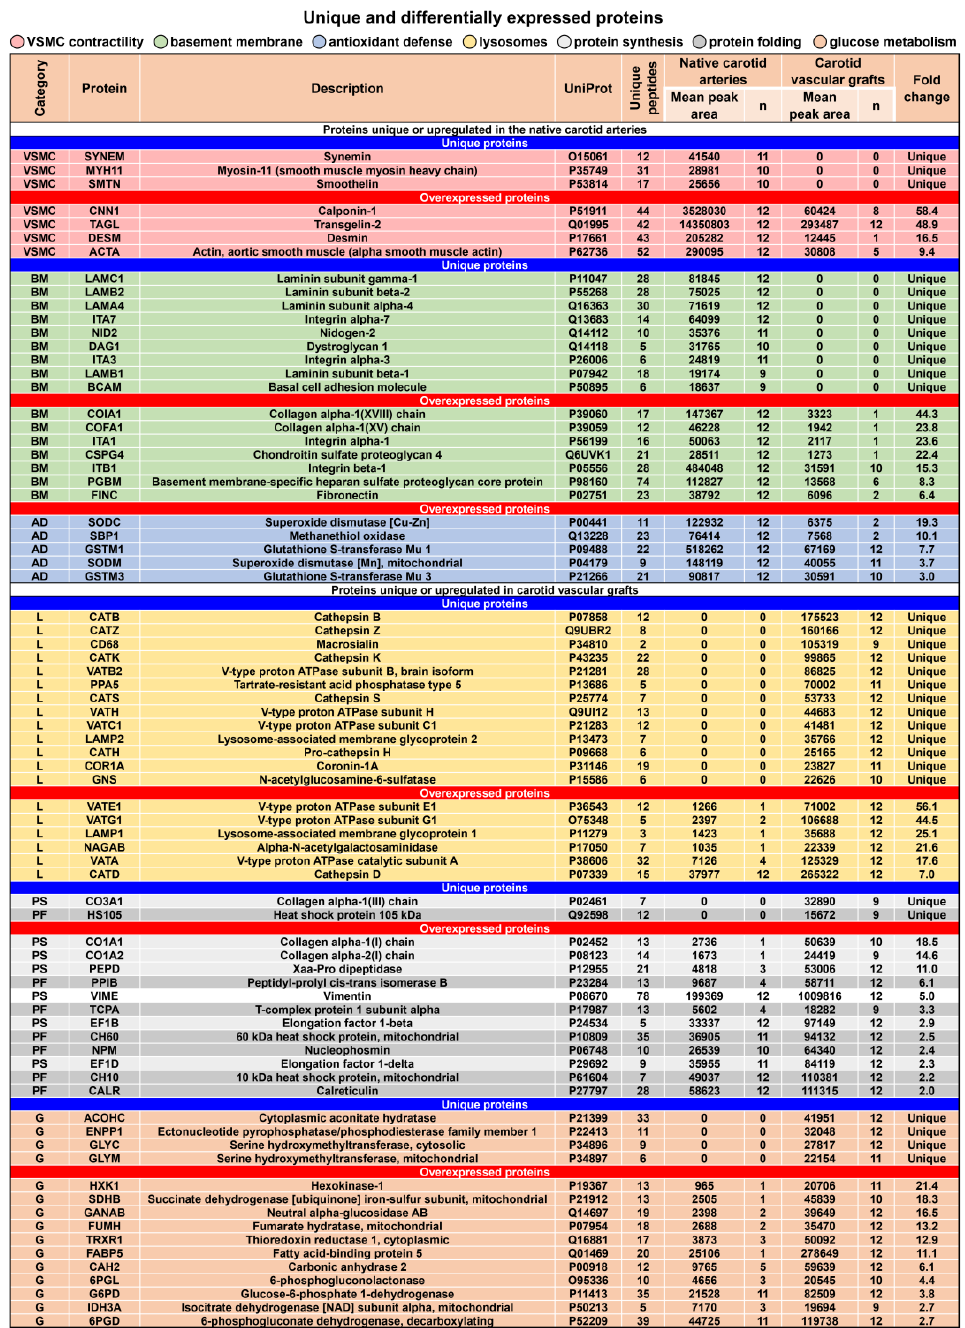
Figure 10. Unique and differentially expressed proteins in the native carotid arteries and TEVGs. Note the overrepresentation of contractile markers representing VSMC markers (pink colour), basement membrane components (green colour), and antioxidant defense proteins (blue colour) in the native carotid arteries and upregulation of lysosomal markers (yellow colour), proteins responsible for the protein synthesis (white colour) and folding (gray colour), and glucose metabolism regulators (orange colour) in TEVGs. For the proteins upregulated in the native carotid arteries, fold change is calculated as compared with TEVGs; for the proteins overexpressed in TEVGs, fold change is determined as compared with the native carotid